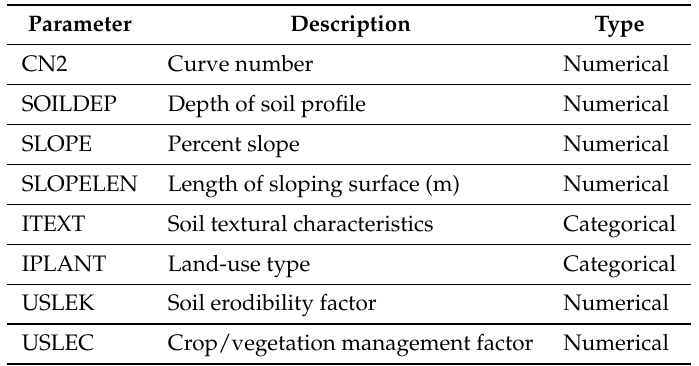
Table 1. Static parameters from Soil & Water Assessment Tool plus (SWAT+) hydrologic input datasets used as features for the multilayer perceptron (MLP)